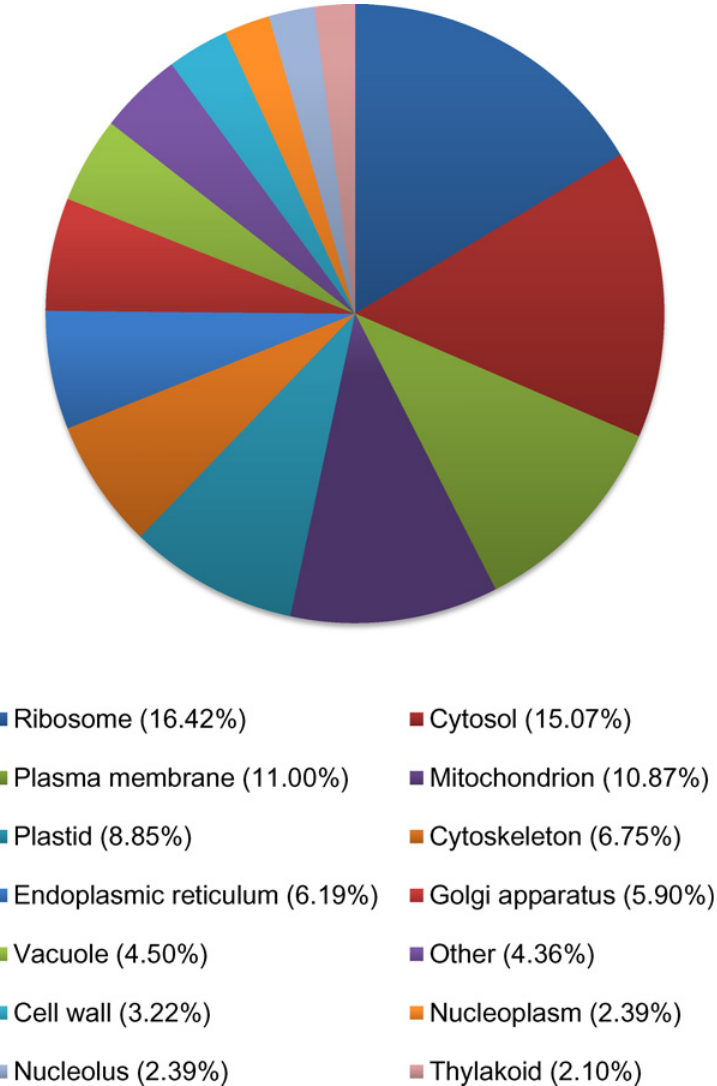
grouped together and classified as “ other ”